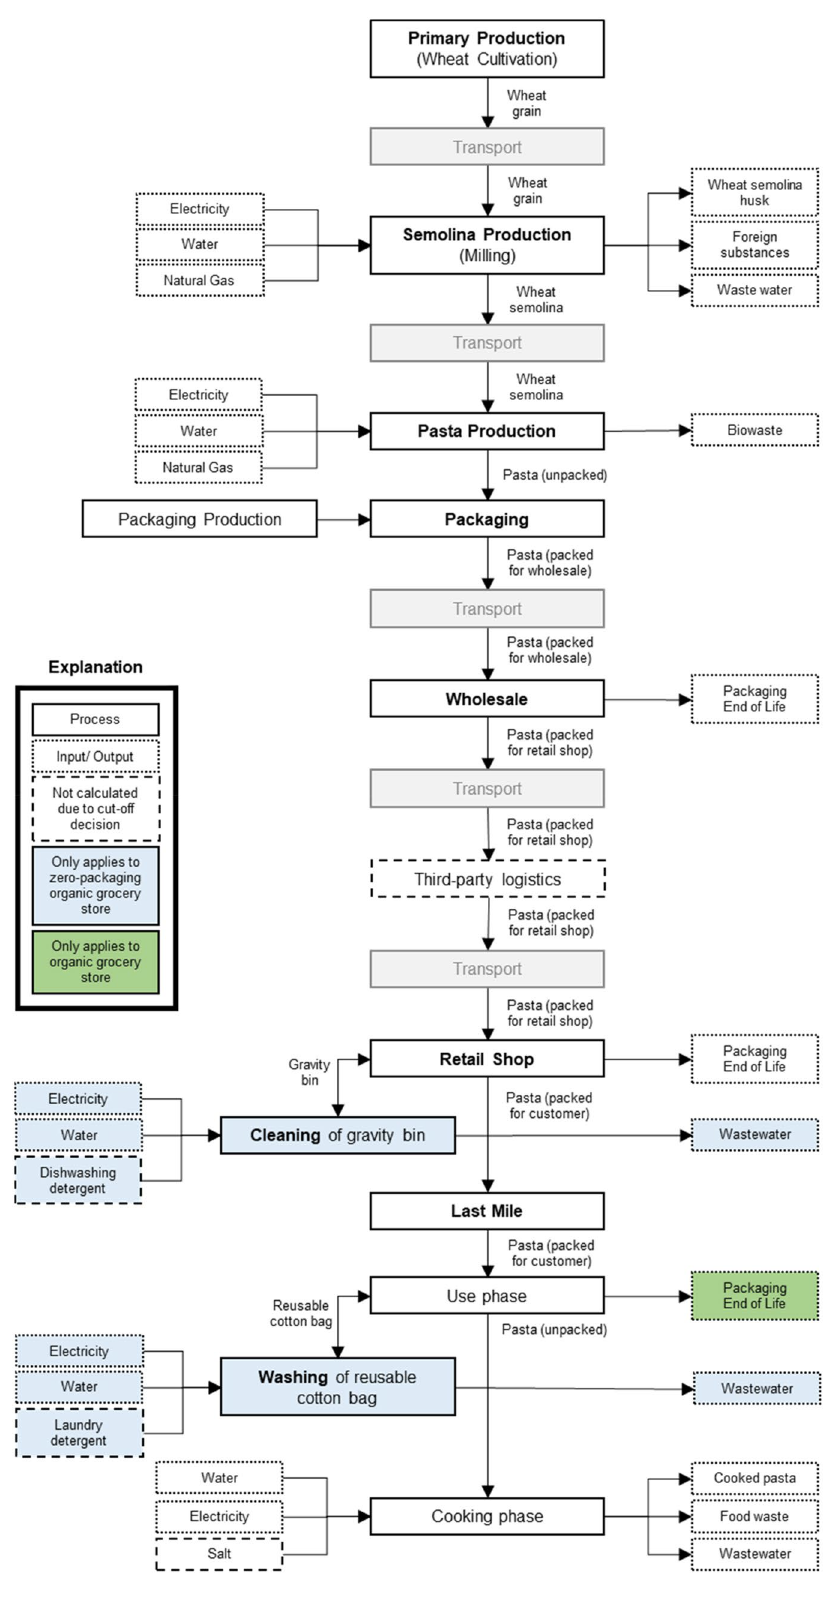
Fig. 1 Process flow diagram and system boundaries of organic durum wheat semolina pasta for both scenarios UP (zero-packaging organic grocery store) and P (organic grocery store). The diagram only shows major inputs and outputs. Please see bullet points at the end of Sect. 2.2 for a list of excluded processes. Inputs and outputs that fall below the cut-off criteria are mostly not shown. For material flows in detail see supplemen- tary file 1. At the end cooked pasta is consumed, therefore leaving the system as virtual flow not shown here. The transport processes between wholesale and retail shop are combined to a single transport process in the